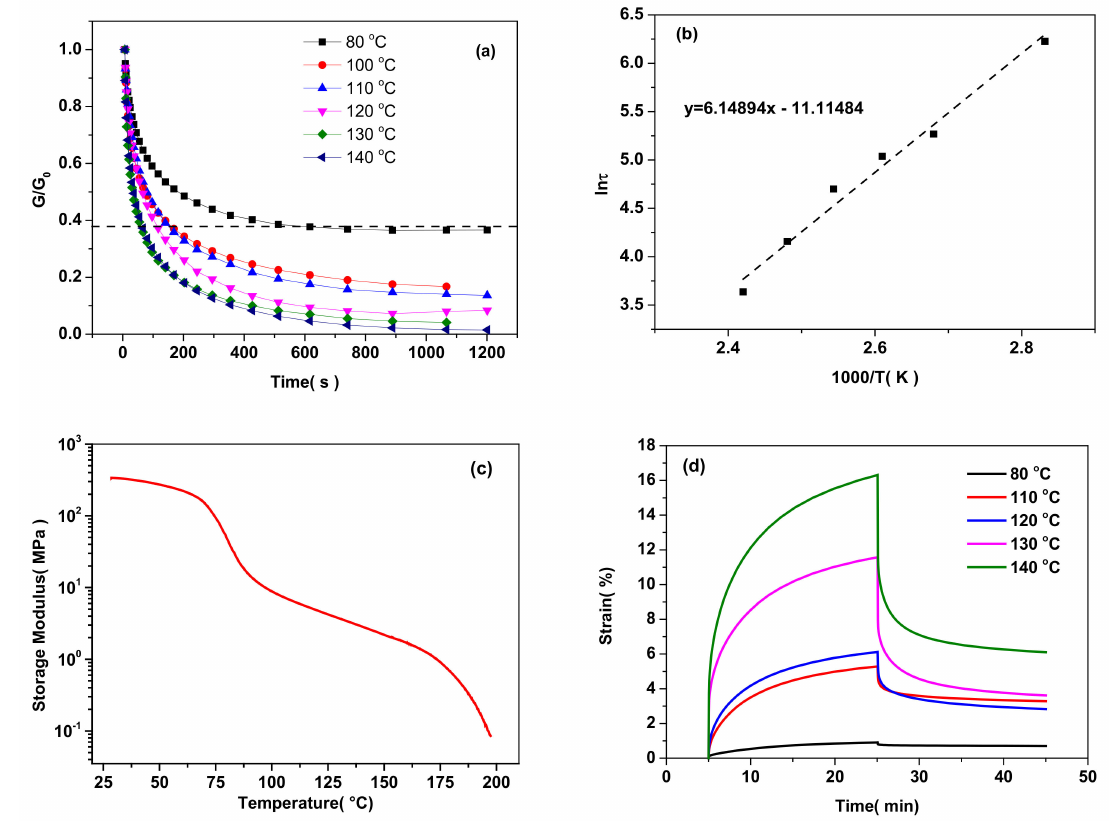
Figure 7. ( a ) Stress relaxation tests of the semi IPNs 6%CPSFTPU 1 at different temperatures, ( b ) Arrhenius plot with linear fit. From this fit the activation energy is calculated to be 55.3 kJ mol − 1 , ( c ) DMTA trace with a continually decreased storage modulus of semi IPNs 6%CPSFTPU 1 , ( d ) creep tests at different